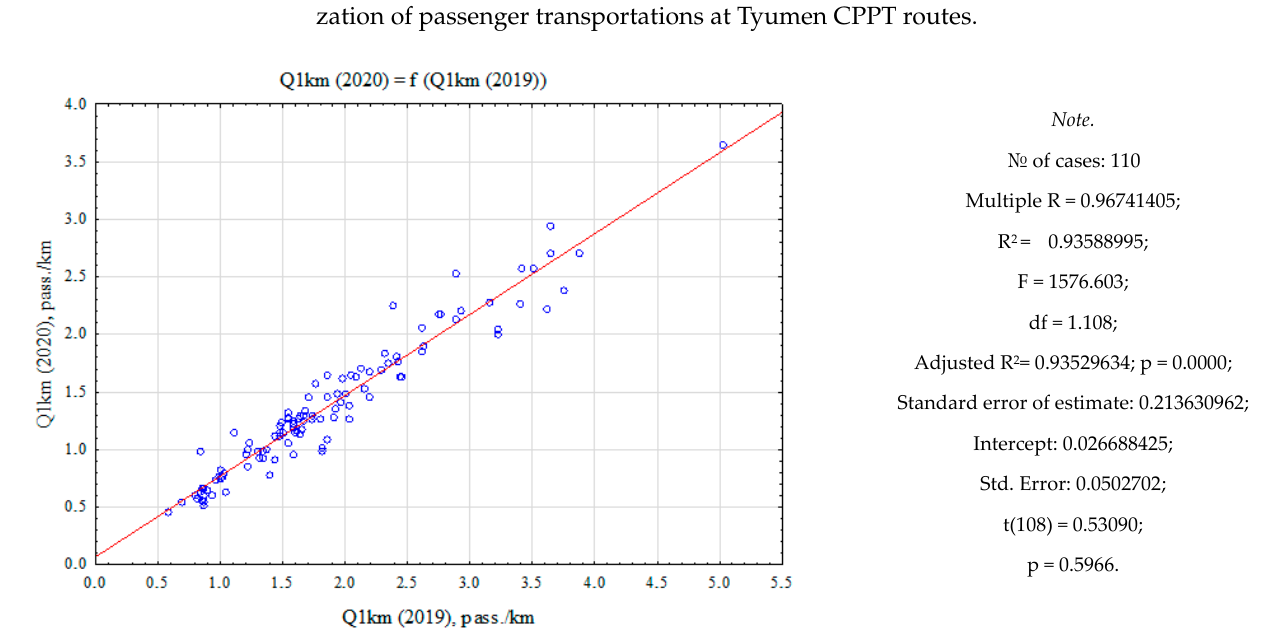
Figure 16. Mathematical dependence Q 1km 2020 = 0.069 + 0.7022 · Q 1km 2019 . According to statistics values, a decrease of values of Q 1km (2020) relative to Q 1km (2019)